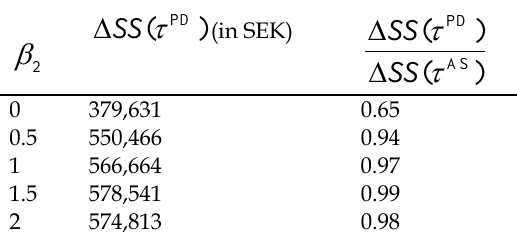
Table 4. Results obtained when solving (14) for the extended Stockholm